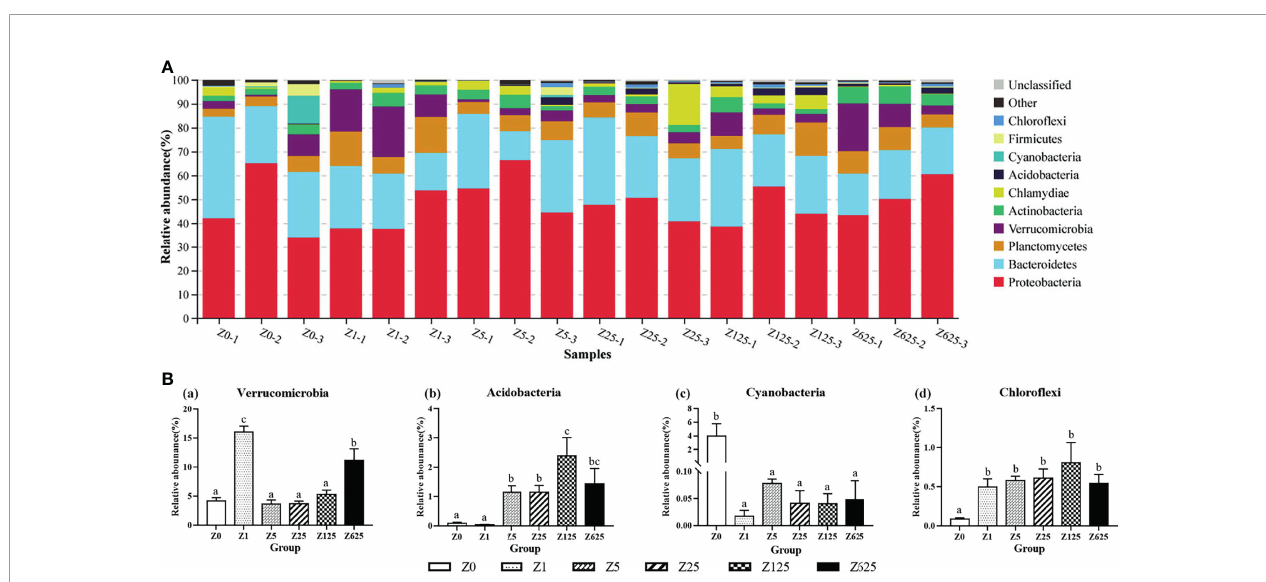
FIGURE 6 | Structure and composition of the intestinal bacterial communities in Litopenaeus vannamei fed different levels of zymosan-A (phylum level). (A) Species distribution stacking of the treatment groups. (B) Relative abundances of the top 10 phyla. Different letters indicate signi fi cant differences ( p <